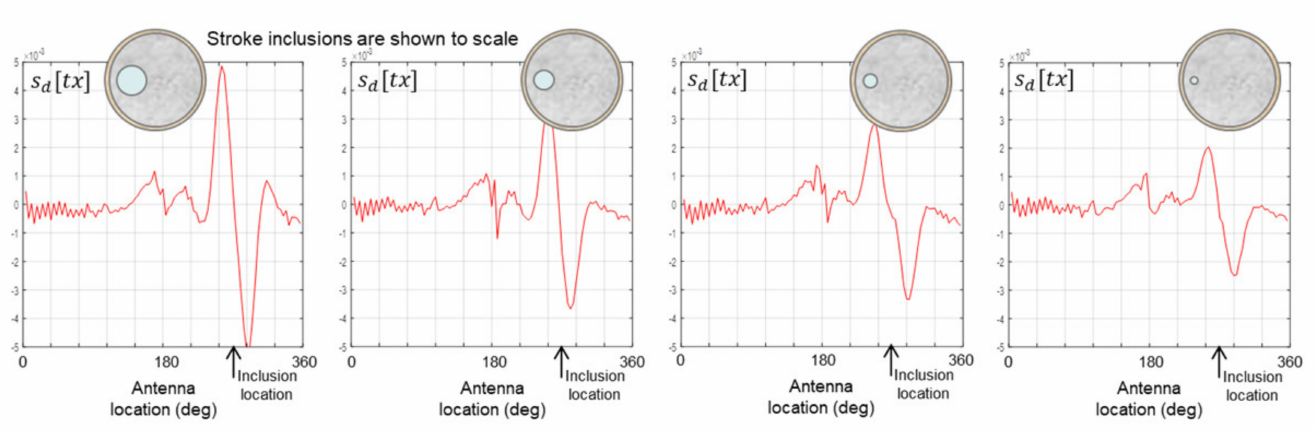
Figure 13. Data from scans of the 150 mm phantom with inclusion sizes of 44 mm ( left ), 30 mm, 21 mm, and 11 mm ( right